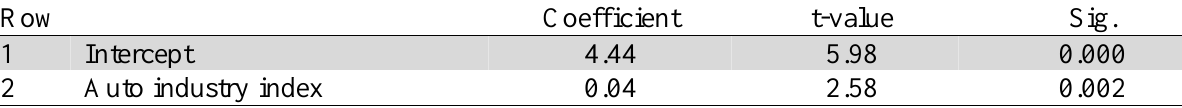
The summary of the results of ADRL